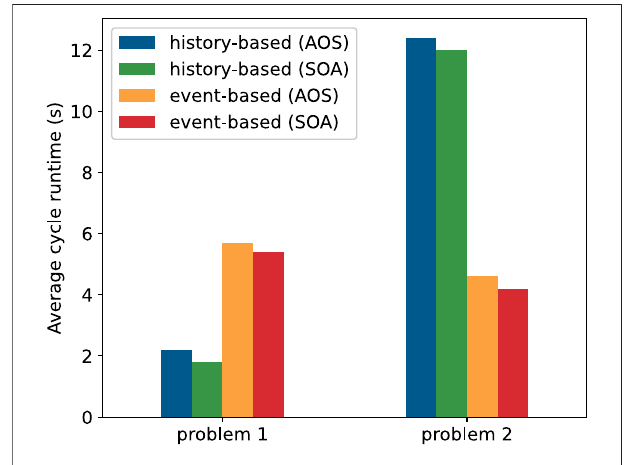
FIGURE 1 | AoS vs. SOA on Nvidia Tesla K80